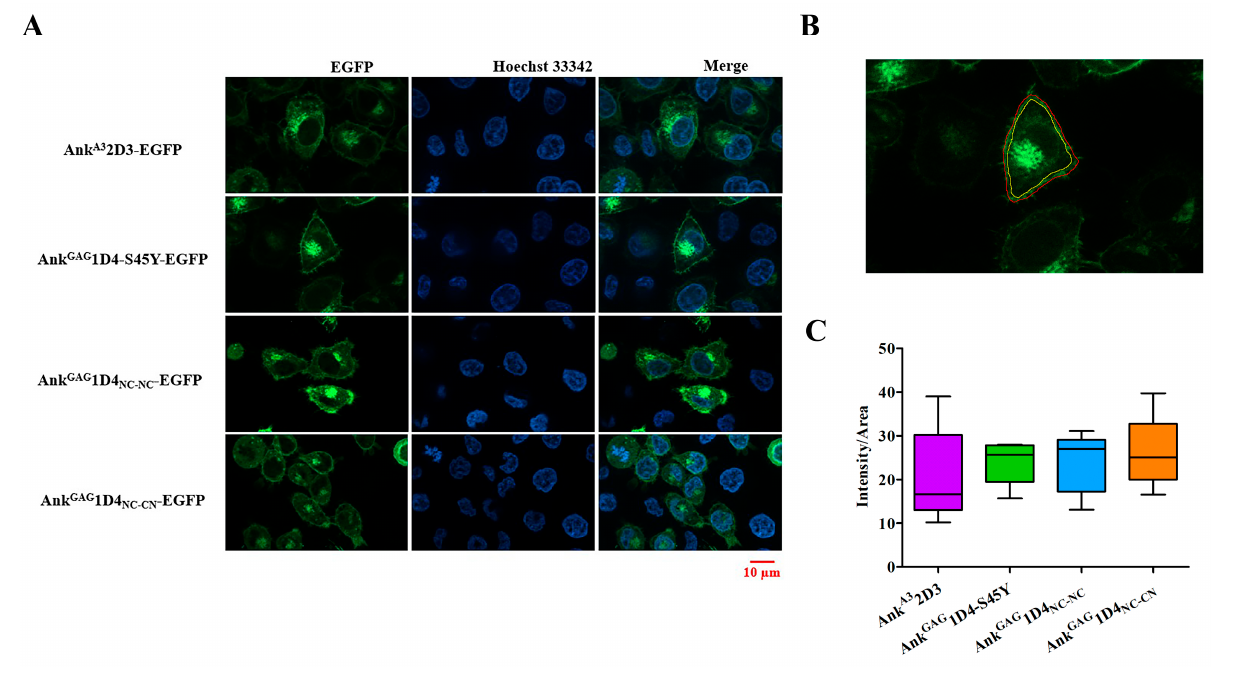
Figure 6. Ankyrin localization in HeLa cells. At 48 h post-transduction, ankyrin-expressing HeLa cells were stained with Hoechst 33342: ( A ) ankyrin localization in HeLa cells was determined under Zeiss Colibri 7 at 100× magnification with Apotome. Green represents ankyrin-EGFP expression, and blue indicates the nucleus of HeLa cells; ( B ) EGFP intensity in a ring was determined by subtracting the intensity of the outer ring (Red line) and inner ring (yellow line); ( C ) The EGFP intensity per area (Intensity/Area) in each ankyrin-expressing HeLa cell was calculated ( n = 5) as follows: (outer ring intensity-inner ring intensity)/(outer ring area-inner ring area). Scale bar: 10 µm. Ank A3 2D3, Ank GAG 1D4-S45Y, Ank GAG 1D4 NC-NC and Ank GAG 1D4 NC-CN represent SupT1 cells expressing Myr (+) Ank A3 2D3-EGFP, Myr (+) Ank GAG 1D4-S45Y-EGFP, Myr (+) Ank GAG 1D4 NC-NC -EGFP, and Myr (+) Ank GAG 1D4 NC-CN -EGFP, respectively.